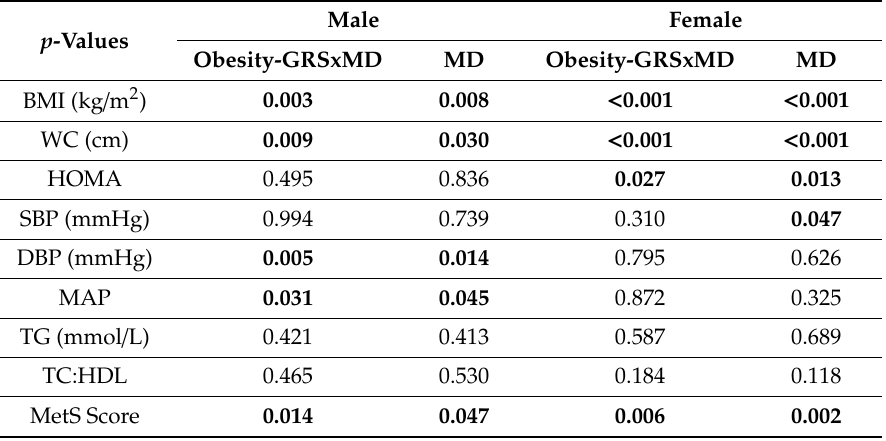
Table 2. Multiple linear regression models of obesity-related genetic risk score (obesity-GRS) and Mediterranean diet (MD) interaction, and the MD e ff ect alone on adiposity and cardiometabolic parameters by